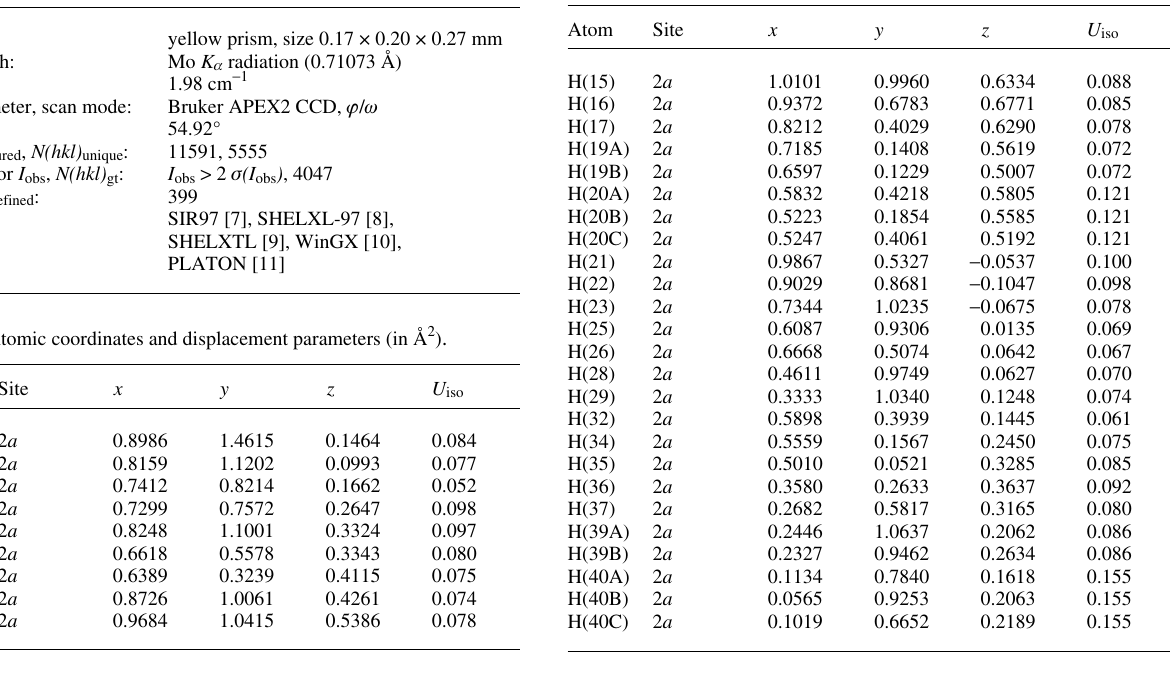
Table 1. Data collection and